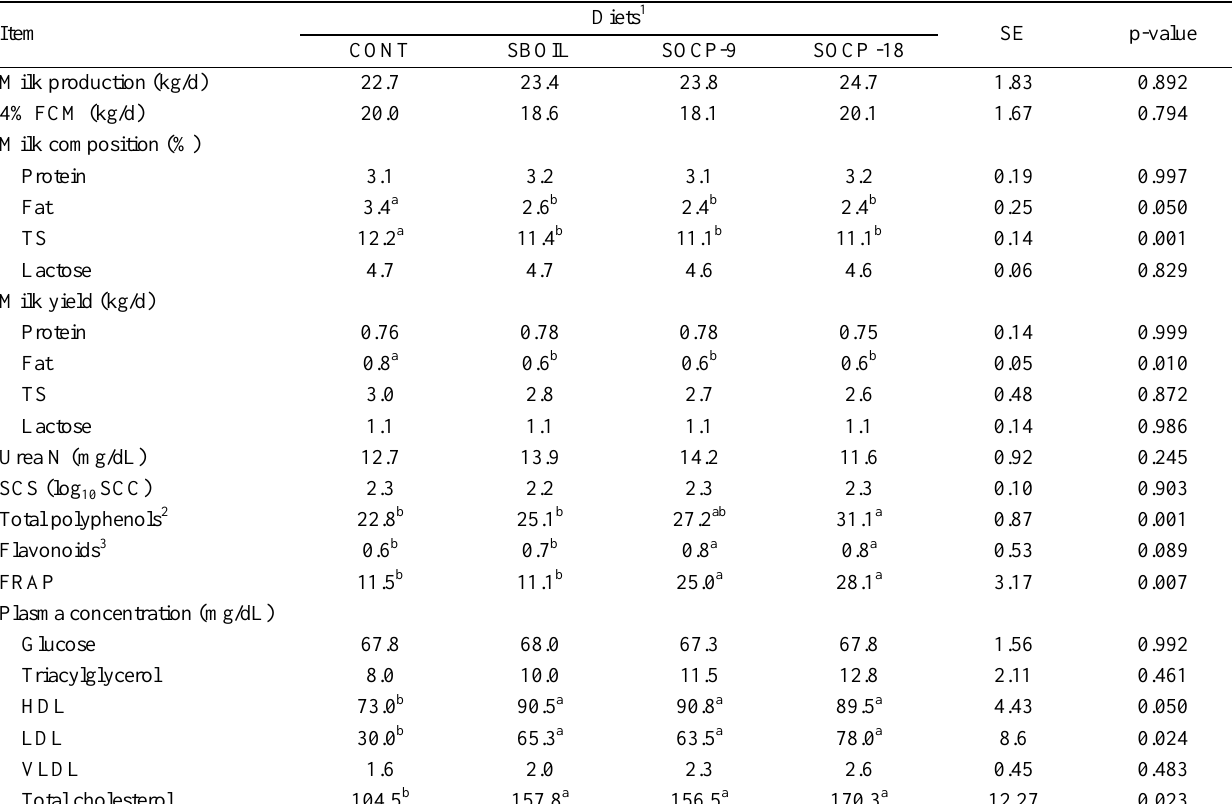
Table 4. Milk production, milk composition and blood composition